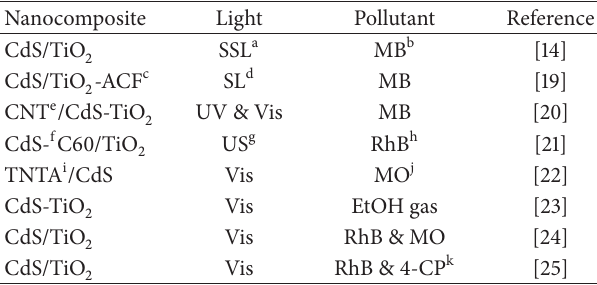
Table 1: Different types of pollutant degraded by CdS/TiO 2 based photocatalysts.